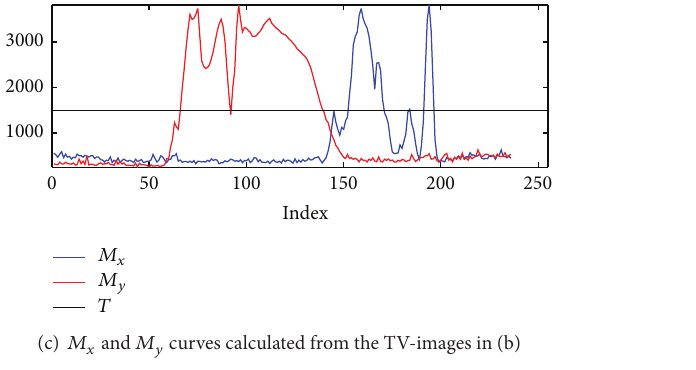
contains only glottis and its neighbours as desired. This